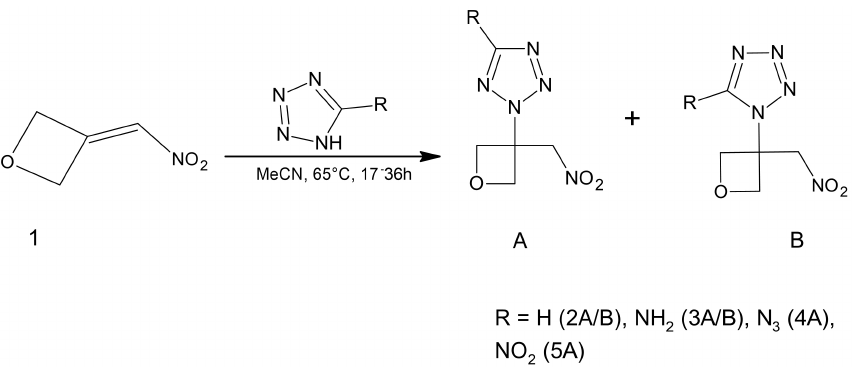
Figure 6. Schematic representation of the synthesis of new energetic oxetane monomers from 3-